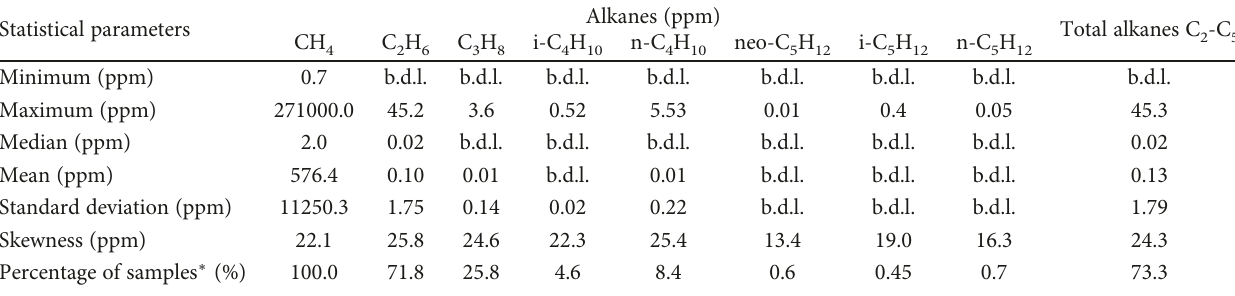
Table 4: Principal statistical parameters of alkane concentrations in analyzed soil gas samples. Statistical